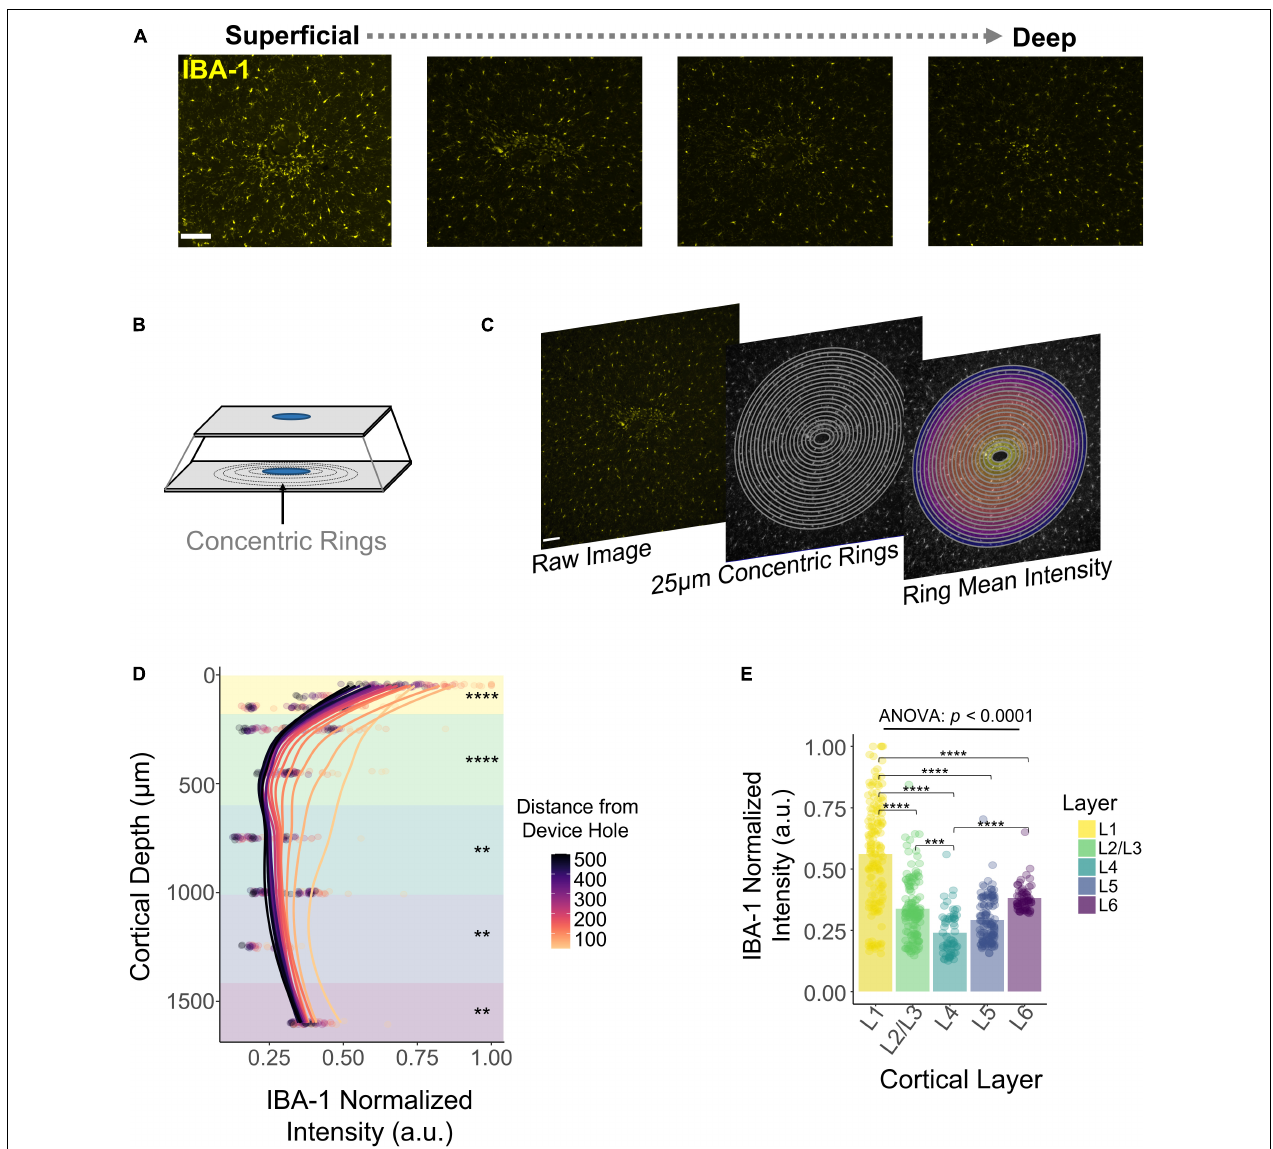
FIGURE 7 | Histological response of microglia and macrophages across cortical depth. (A) Representative histological sections stained with Iba1 for one subject showing a change in fluorescence intensity across cortical depth. (B) Graphical representation of concentric rings around the explanted device hole. (C) Concentric rings and mean intensity calculation from a representative tissue section. (D) Quantification of Iba1 fluorescence intensity with respect to the distance from the device hole across cortical depth. Lines represent a locally fitted polynomial regression of the mean of each concentric ring. (E) Quantification across layers of the Iba1 fluorescence intensity. Analysis of variance and pairwise comparisons between layers were performed with a one-way ANOVA with Tukey’s post-hoc test. ** p ≤ 0.01, *** p ≤ 0.001, **** p ≤